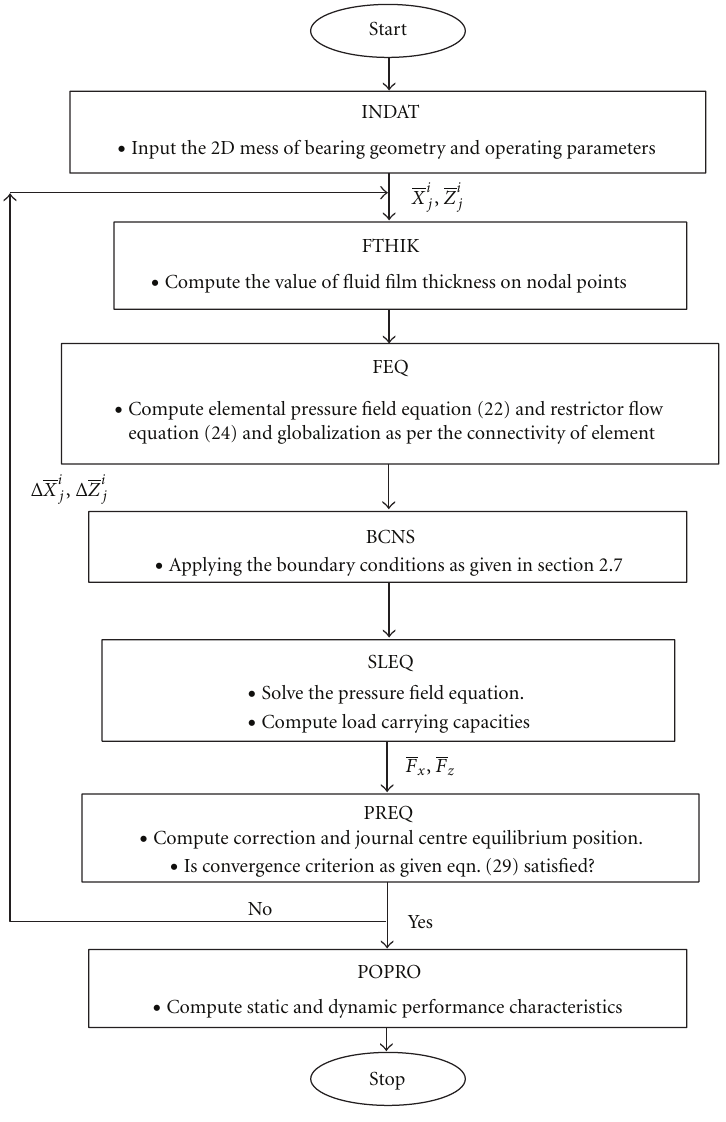
Figure 3: A flow chart to describe the overall solution